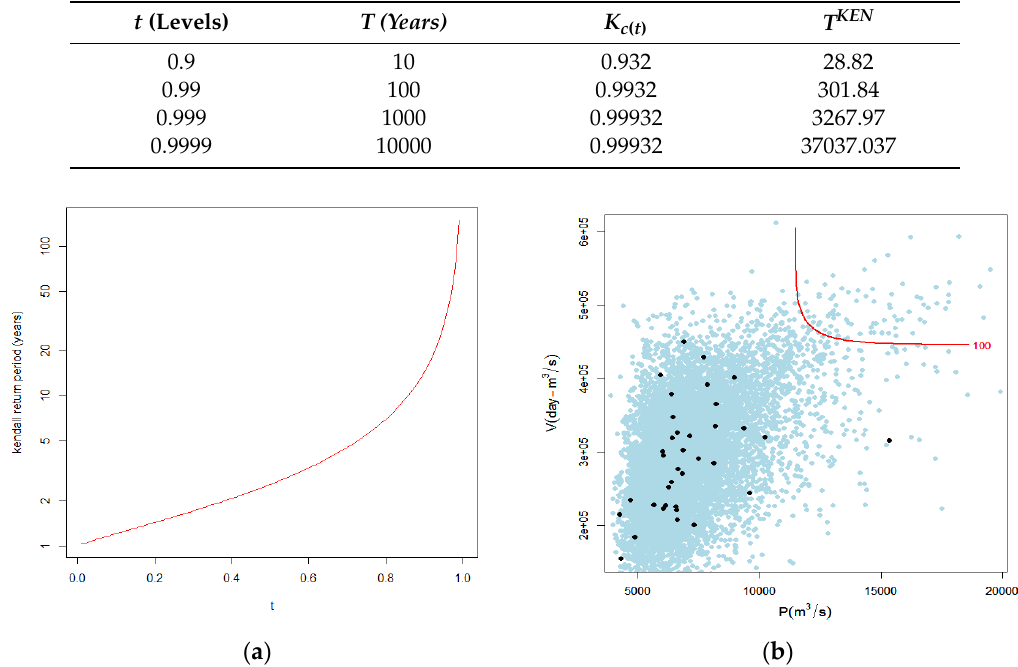
Figure 8. ( a ) The plot between t (levels) and Kendall return period. ( b ) The contour plot of the peak and volume for the secondary return period over 100 years.